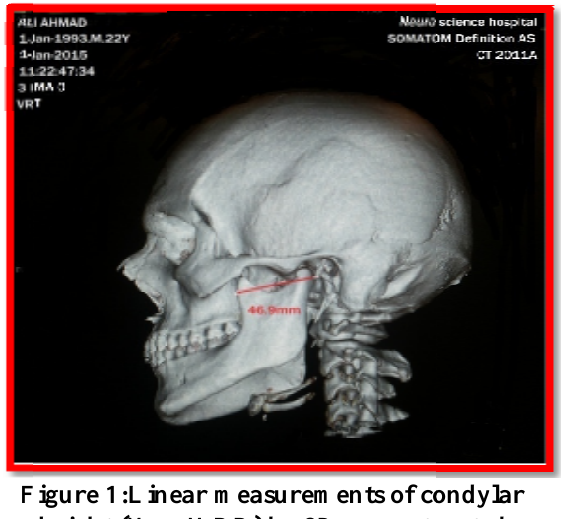
Figure 1:Linear measurements of condylar